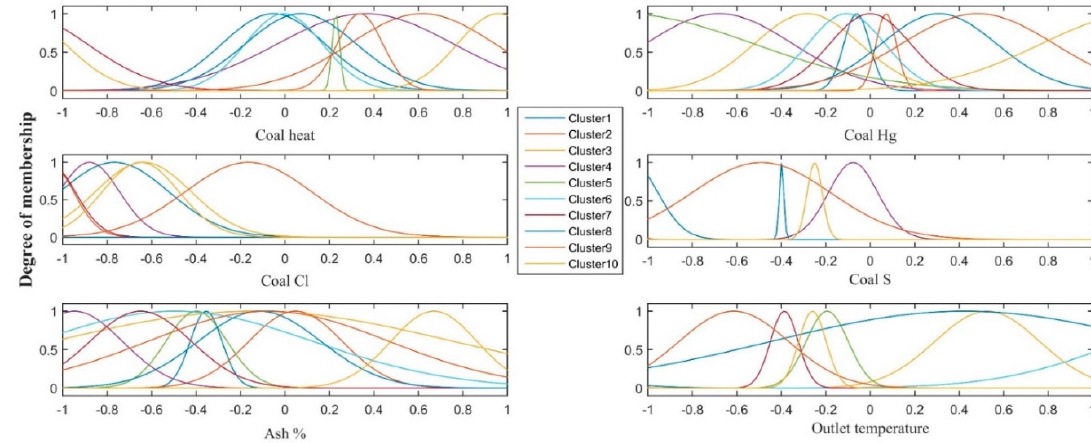
Figure 4. Trained membership function parameters.